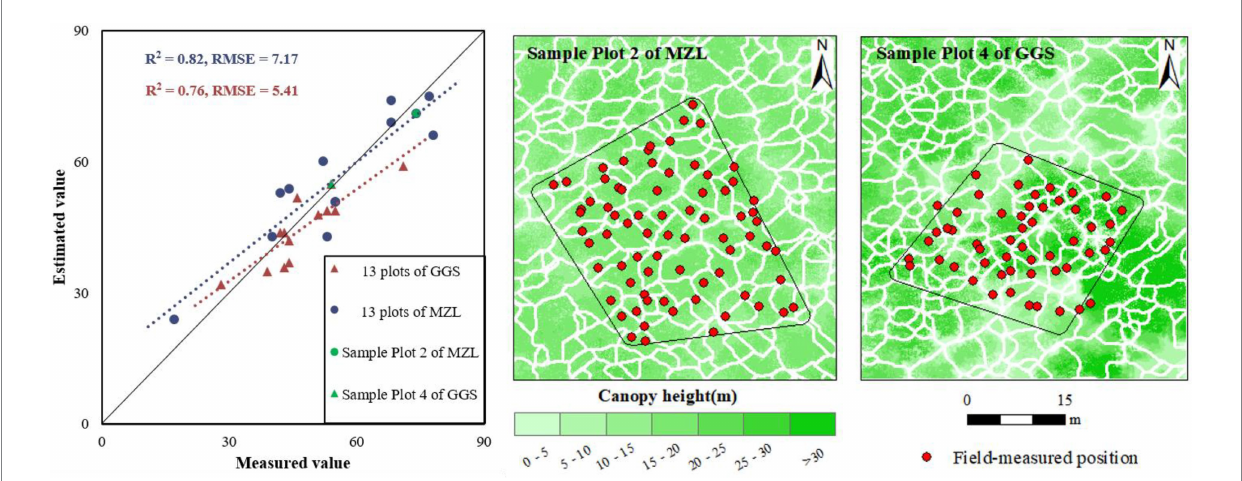
FIGURE 2 Scatter diagram for verification of ITCs (left) and results of individual tree separation in sample plot 2 of MZL (middle) and sample plot 4 of GGS (right) (black boxes represent the boundaries of plots, white polygons refer to the segmented tree crowns, and red points represent the field-measured positions at the base of tree